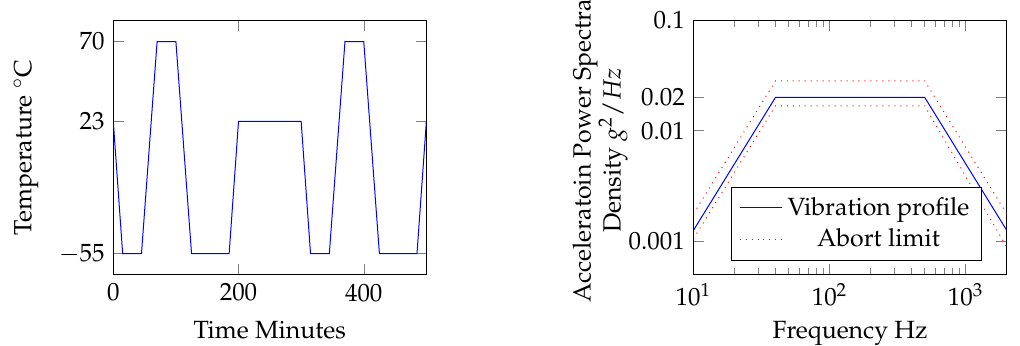
Figure 1. Test profiles for thermal shock ( left ) and random vibration profile ( right ), slops ± 6 dB/octave. Integrity and Robustness